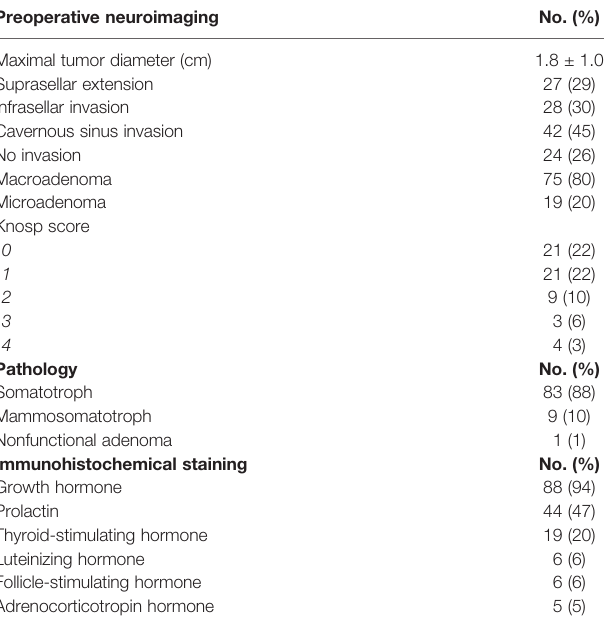
TABLE 2 | Preoperative neuroimaging, pathology, and immunohistochemical